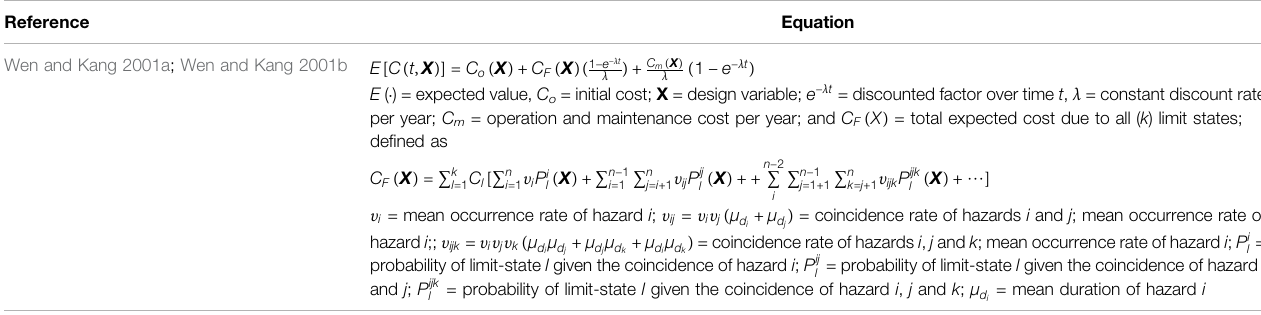
TABLE 2 | LCC performance based design framework. Reference Equation Wen and Kang 2001a; Wen and Kang 2001b E [ C ( t , X )] (cid:2) C